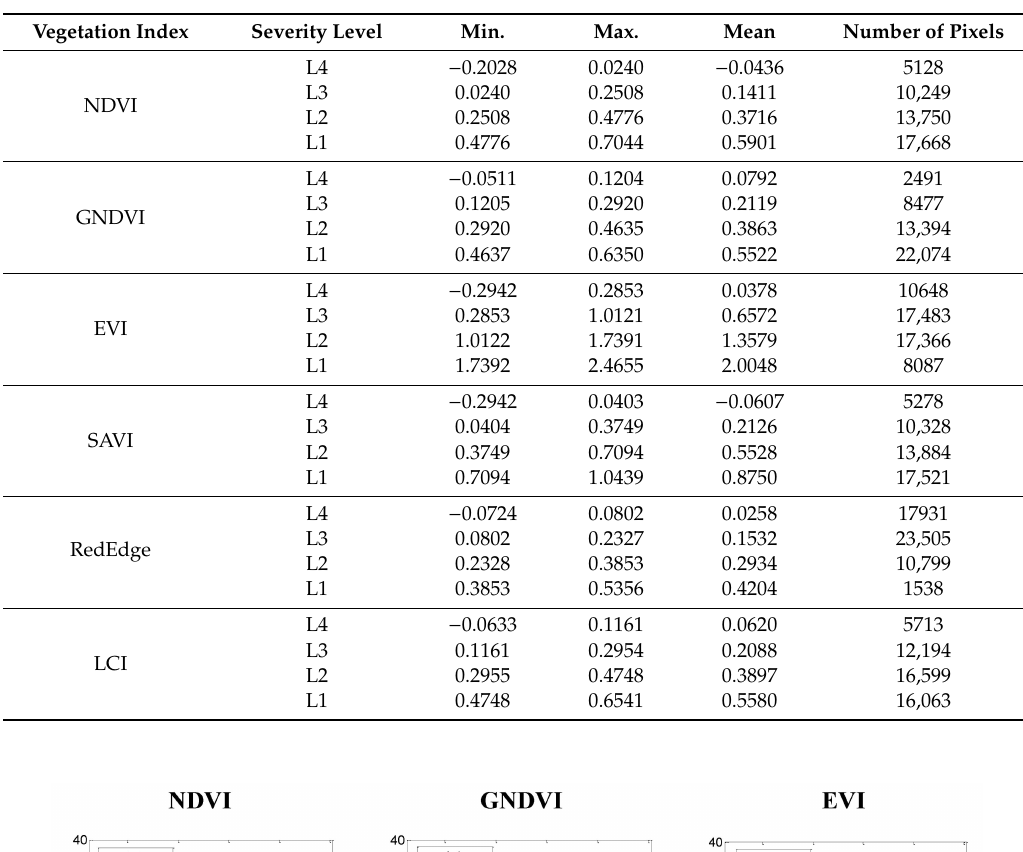
Table 5. Descriptive statistics of di ff erent severity levels of cotton root rot in Field B.